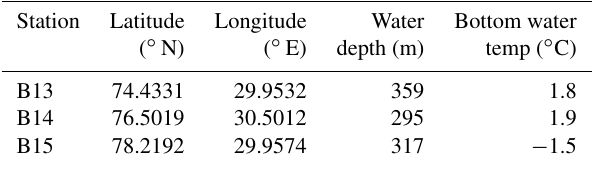
Table 1. Sampling station information averaged across the three Changing Arctic Ocean Seafloor (ChAOS)